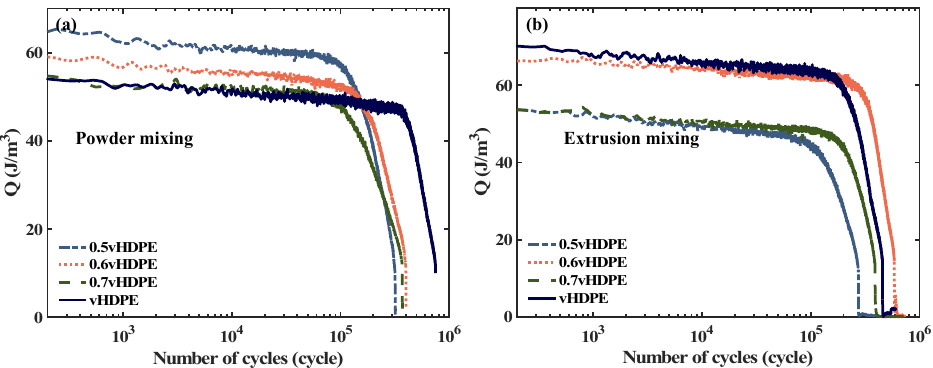
Figure 11. Heat generation as a function of the number of cycles for different vHDPE content during fatigue testing at ε 0 = 0.24%, R = 0.3 and f = 5 Hz for the blends produced via: ( a ) powder mixing and ( b ) extrusion mixing.